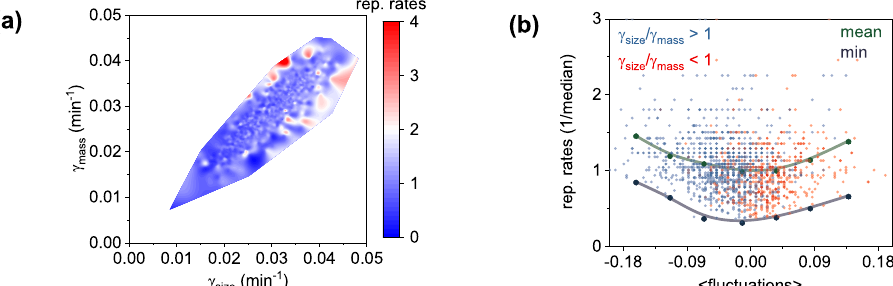
Fig. 4 Density fl uctuations impact replication rates of single bacteria. a 3D representation of growth differentiation ( γ A − γ Μ relationship), with each single-cell observation color coded by its replication rate level; graph represents the cumulative response of three replicates with each replicate presented separately in Supplementary Fig. 13. b Single-cell replication rates plotted as a function of density fl uctuations; blue and red data points represent single-cell observations (color coded by their level of differentiation); green and purple points represent the averaged binned data and minimum replication rates levels at different levels of fl uctuations; similarly, graph plots the combined three replicates, with each replicate presented separately in Supplementary Fig.